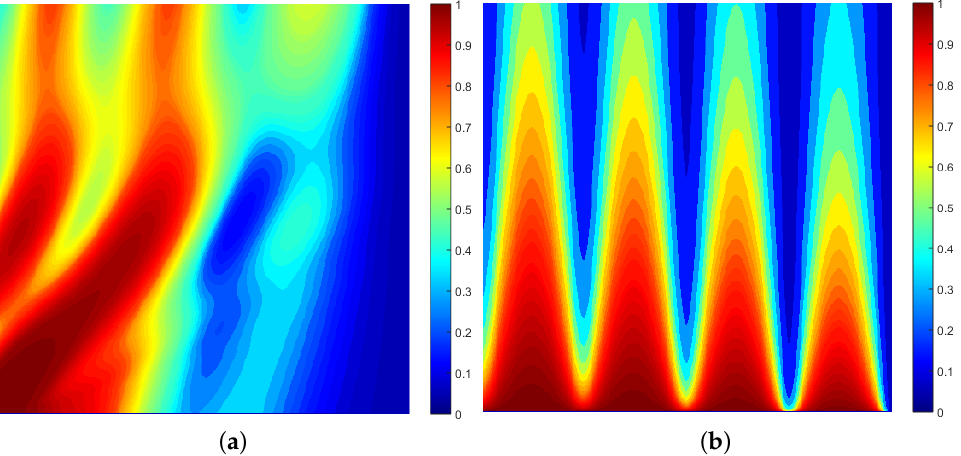
Figure 7. Example of two solutions given by Equation (72). In both cases, the horizontal axis and the vertical axis, are of space x and time t , respectively, where ( 0,0 ) is the lower left-hand corner of the map. ( a ) Space-time map of the function | u α ( x , t ) | 2 , x ∈ [ 0,1 ] , t ∈ [ 0 + ,1/ k ] where u α ( x , t ) is given by Equation (72) for k = 4 π and α = 0.9; ( b ) space-time map of the function | u α ( x , t ) | 2 , x ∈ [ 0,1 ] , t ∈ [ 0 + ,1/ k ] , where u α ( x , t ) is given by Equation (72) for k = 4 π and α =